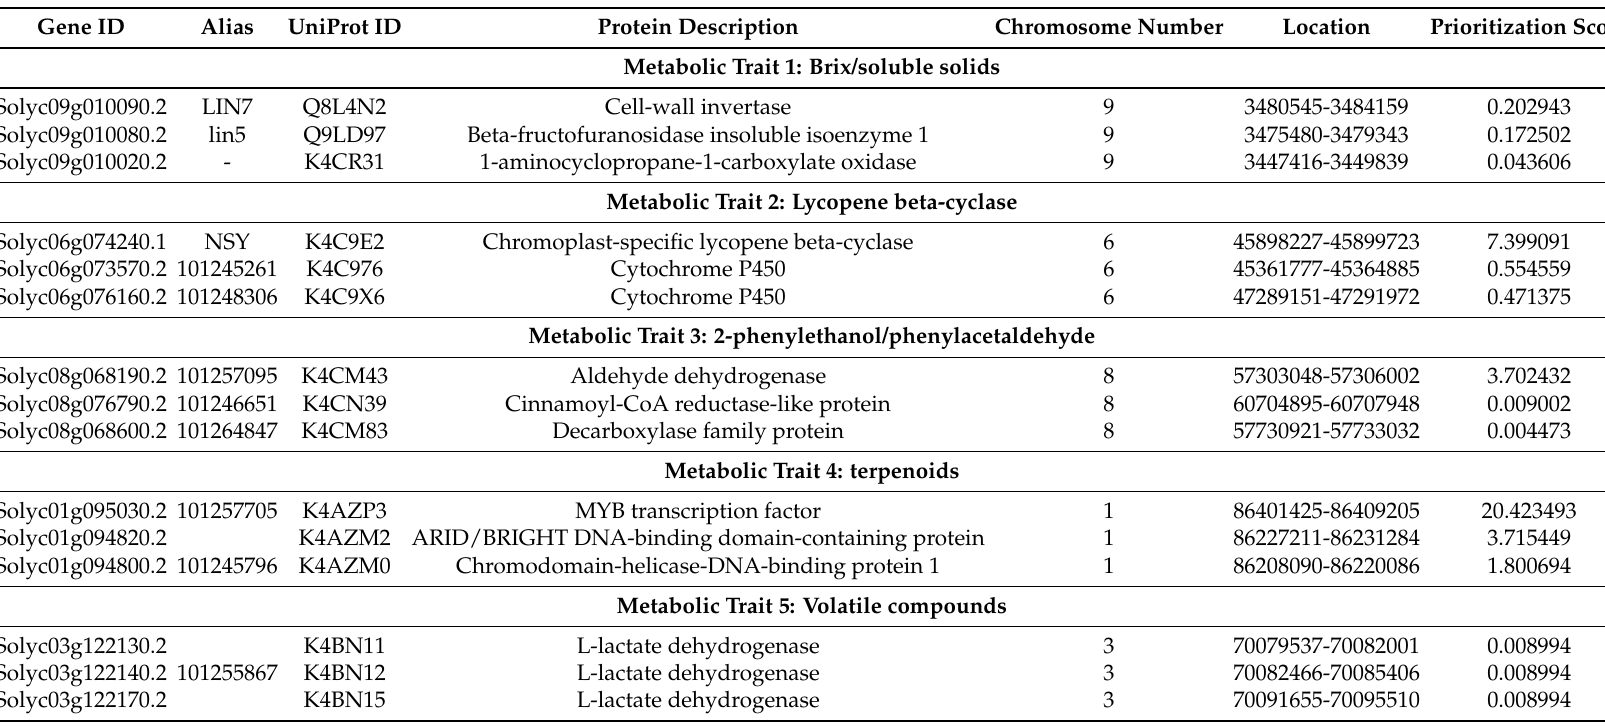
Top three candidate genes found for the five selected metabolic traits (Brix/soluble solids, lycopene beta-cyclase activity and